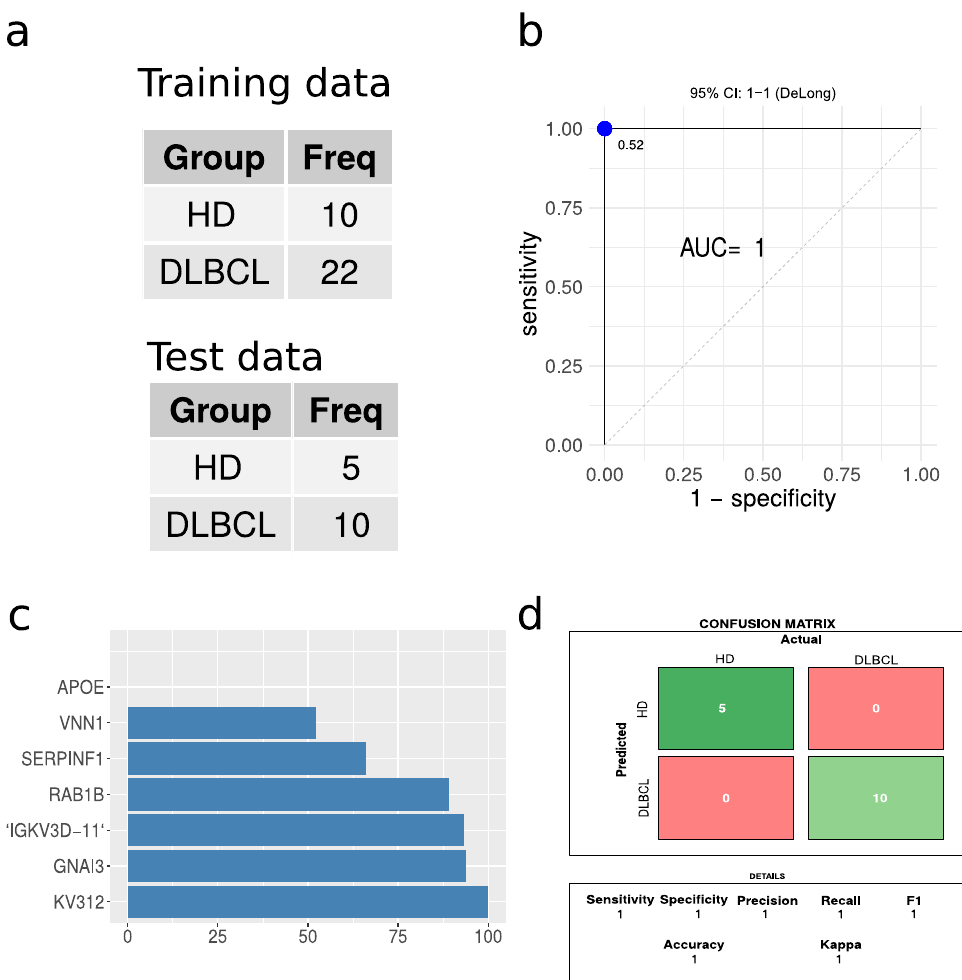
Figure 7. Performance of partial least squares regression analysis. ( a ) A summary of the training and test data sets used. ( b ) Receiver operating characteristics for the PLS regression model. The blue dot indicates the threshold based on Youden’s J statistic. ( c ) The top ten protein features in terms of importance. ( d ) The confusion matrix and the performance parameters associated with it.